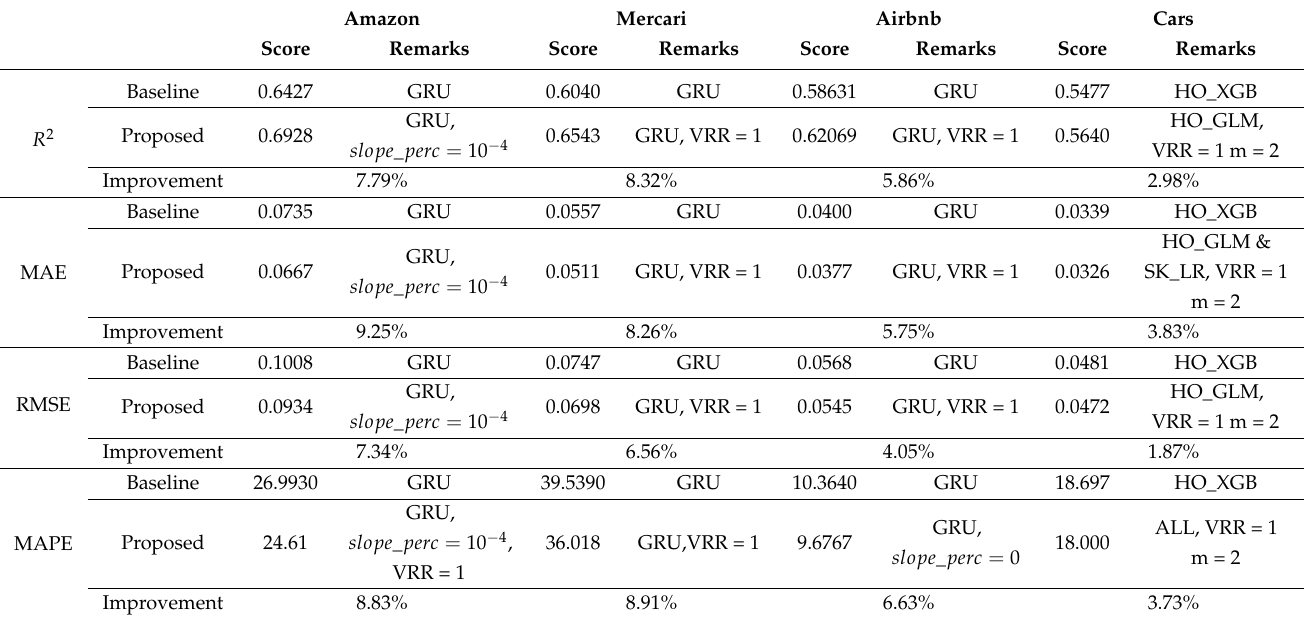
Table 3. The best achieved results.